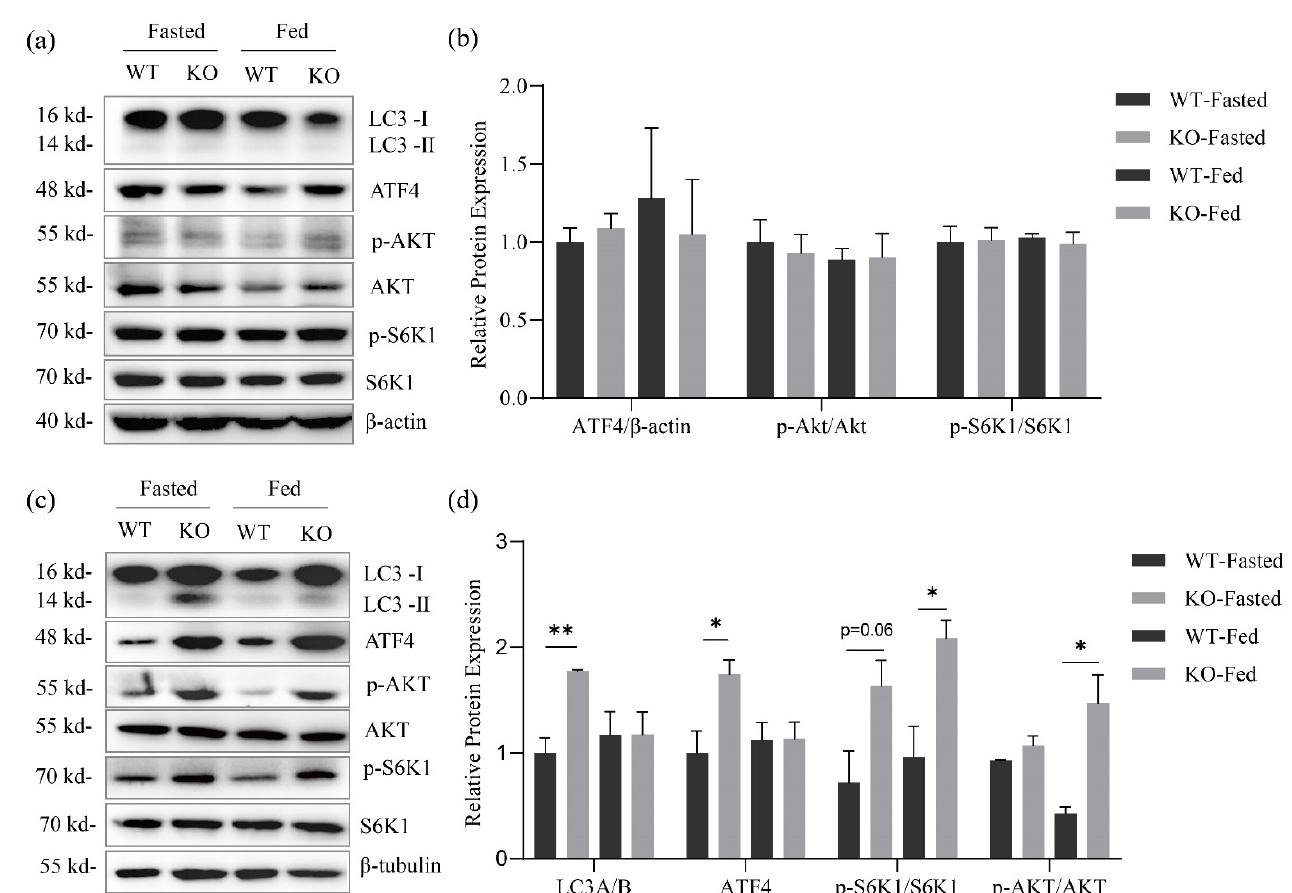
Figure 5. Effects of GPRC6A on tissue protein expression in 8-week-old mice under fasting and re-feeding condition. ( a ) Western blots of mice liver protein expression. ( b ) Statistics of mice liver protein expression. ( c ) Western blots of mice skeletal muscle protein expression. ( d ) Statistics of mice skeletal muscle protein expression. Phosphorylated proteins were referenced to total proteins, non-phosphorylated proteins were referenced to β -actin or β -tubulin. The data were analyzed by two-way ANOVA and unpaired Student’s t-test under the same feeding state, * p < 0.05, ** p < 0.01, n = 3.